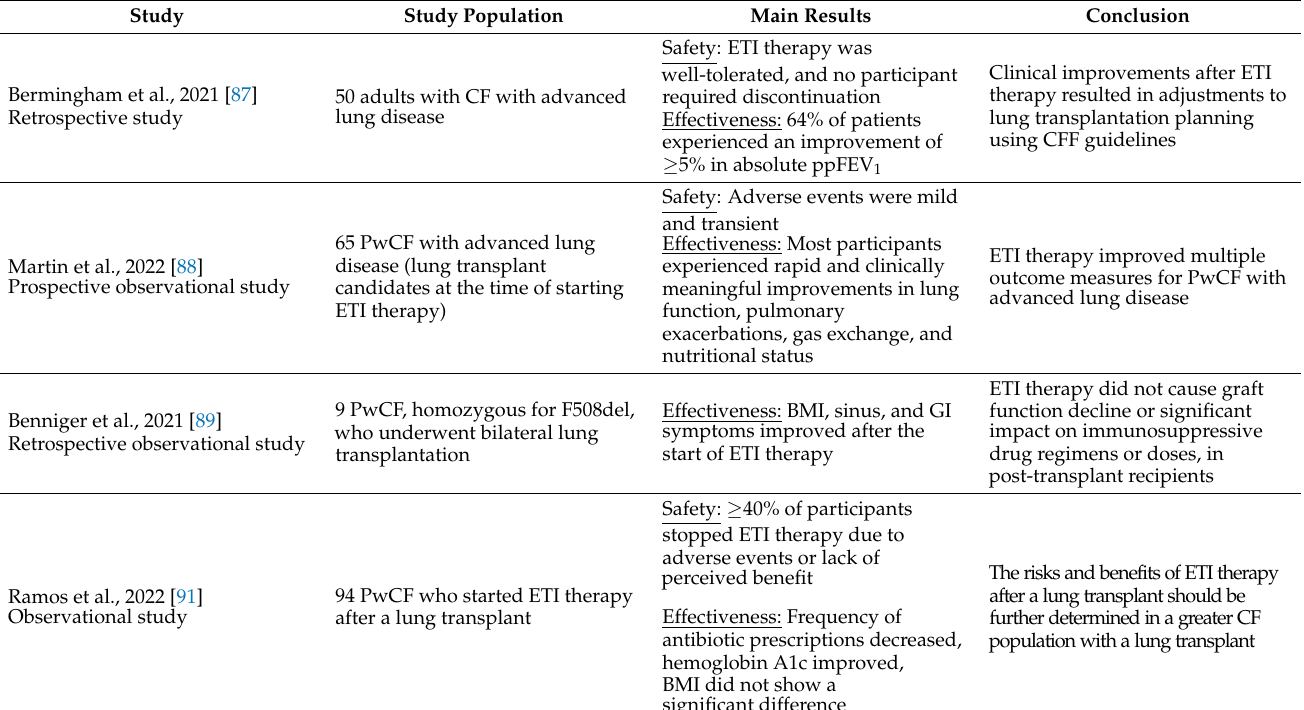
Table 5. Clinical studies assessing the effects of ETI therapy in PwCF referred to the transplant of post-transplant